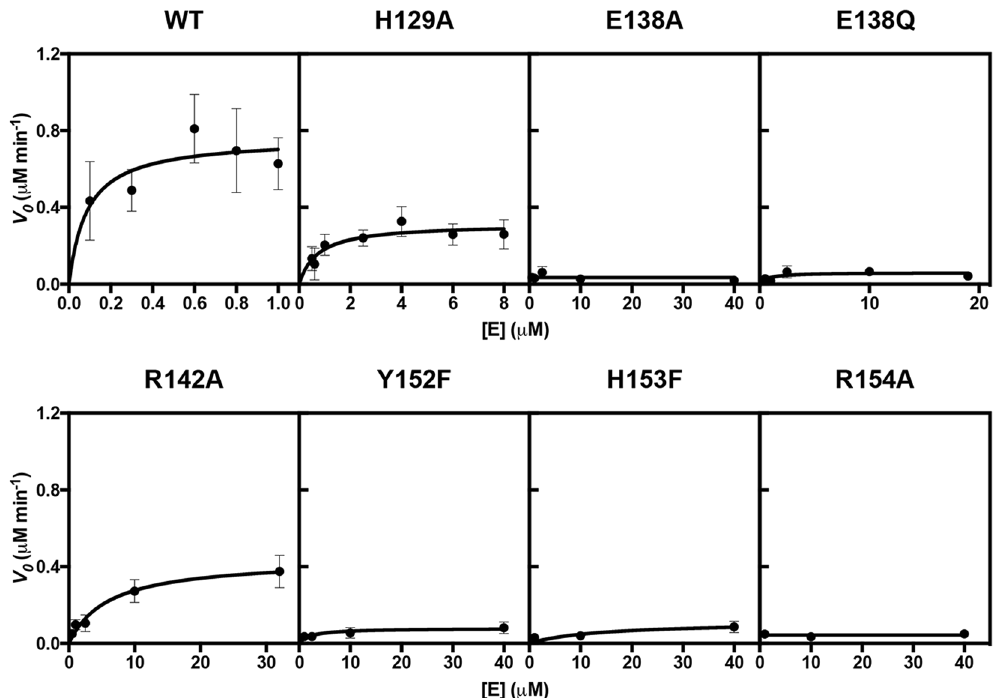
Figure 2. Kinetic analyses of wild-type and mutant RlmH. Initial velocities ( V 0 , µ M min − 1 ) of methylation of Δ rlmH − 70S ribosome (0.3 µ M) by wild-type or mutant RlmH at 25 °C with 50 µ M [ 3 H]-labeled SAM. Error bars show error of fit for two independent experiments.